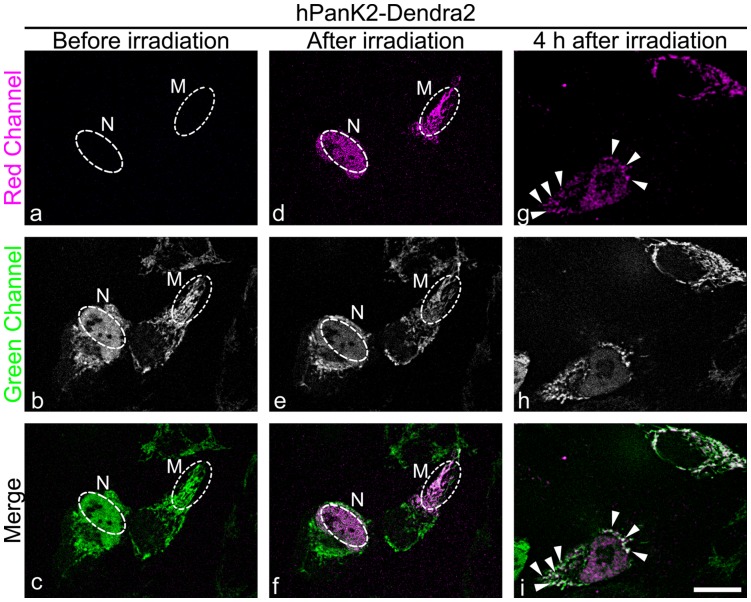
Human PanK2 migrates from nucleus to mitochondria.HeLa cells were transfected with the expression plasmid pAA275 encoding full-length hPanK2(1–570) fused to the green-to-red photoswitchable fluorescent protein Dendra2. The red-irreversibly-converted fluorescence was real-time tracked in living cells. The micrographs show two cells (before irradiation, panels a, b, c) expressing hPanK2-Dendra2, one cell showing “nuclear and mitochondrial” fluorescence and a second cell with “mitochondrial only” fluorescence. Dendra2 was selectively photoconverted within the indicated ROIs (white dashed ovals) for each cell (after irradiation, panels d, e, f) using brief illumination with 405 nm irradiation, and the fusion proteins were visualized in the green and red channels thereafter. After 4 hours (panels g, h, i), the photoconverted nuclear fraction of hPanK2 was associated with mitochondria (arrows, panels g, i) whereas the photoconverted mitochondrial hPanK2 in the other cell remained associated with mitochondria during the same time. Co-localization of both magenta and green hPanK2 fusion proteins associated with mitochondria are indicated by white pixels and arrows in the merged image (panel i). Scale bar, 10 µm.